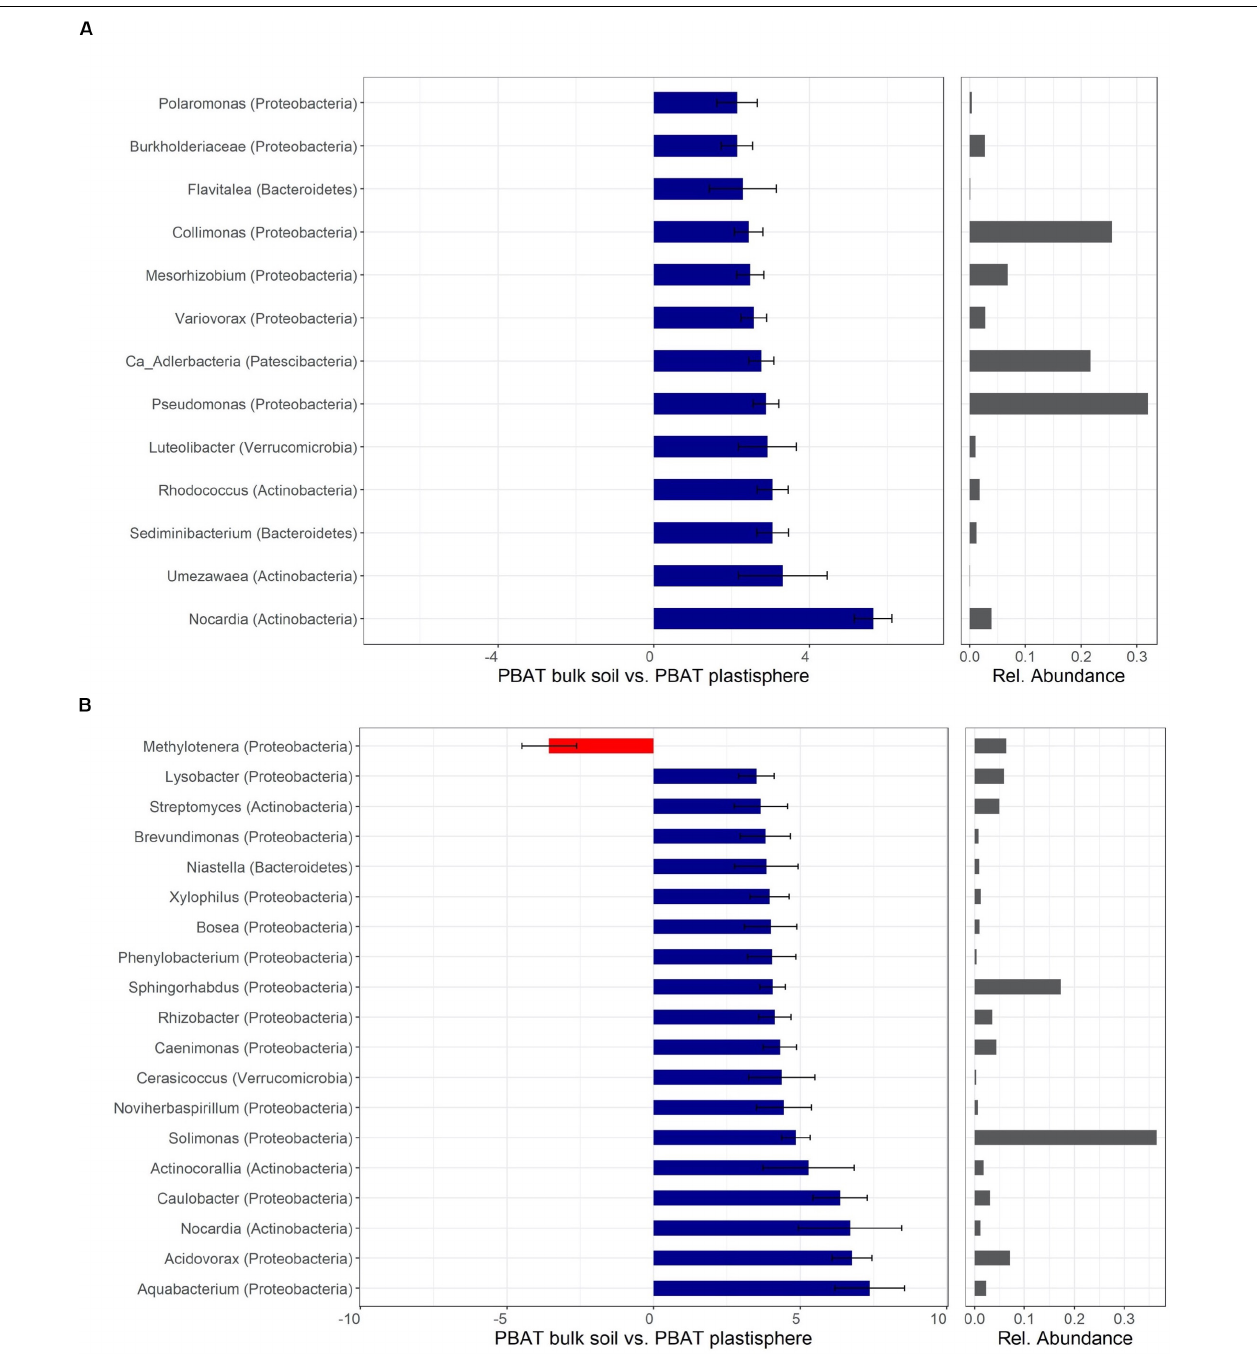
FIGURE 6 | Differentially abundant taxa of PBAT in Barba Peider (Swiss Alps) (A) and Villum (Northern Greenland) (B) soil. Taxa are classified to the lowest possible taxonomic level. Values on the X -axis in the left panels show the differential abundances in the plastisphere and bulk soil as log 2 -fold changes. Only significant taxa ( P < 0.05) with log 2 -fold changes > 2 (A) and > 3.5 (B) are shown. Note that the scales in the x -axis in panels (A,B) are different. Positive values indicate a higher occurrence in the plastisphere, whereas negative values indicate a higher occurrence in the bulk soil. Names in brackets specify the phylum the taxa belong to. Values in the right panels indicate the abundances of specific taxa relative to the taxa shown in the figure. Ca, candidatus. α -diversity on plastics than in the sea water (Zettler et al.,